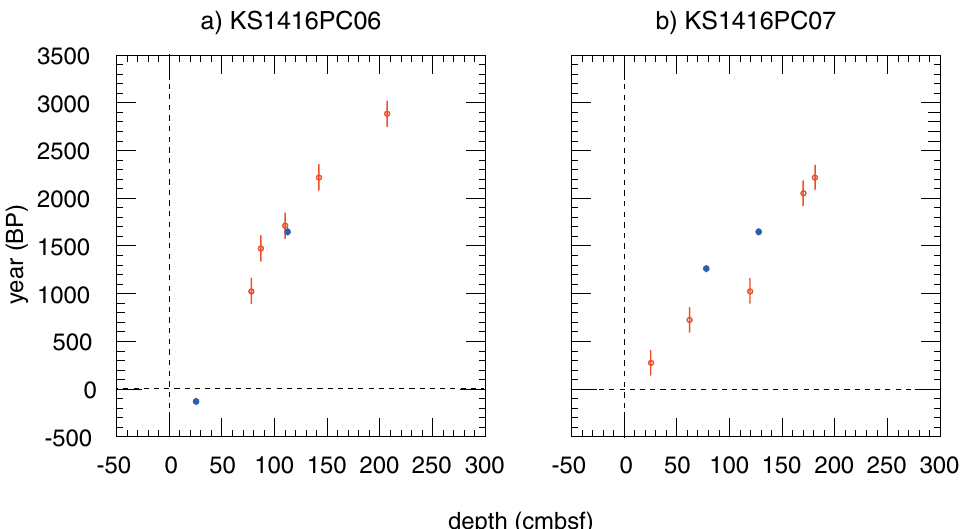
Fig. 7 Ages of offset bulk 14 C dates (blue; Table 3) versus ages derived from PSV (red; Table 2) correlation of cores KS1416PC06and KS1416PC07. Lines in vertical axes (year) show error